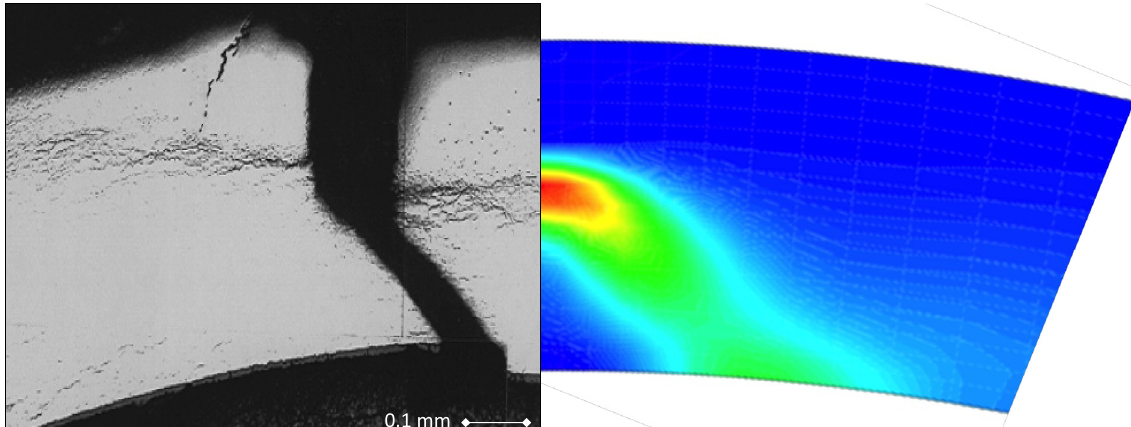
Fig. 5. Clad state at PPN after the REP-Na8 test and calculated equivalent plastic strains at the end of the 2D